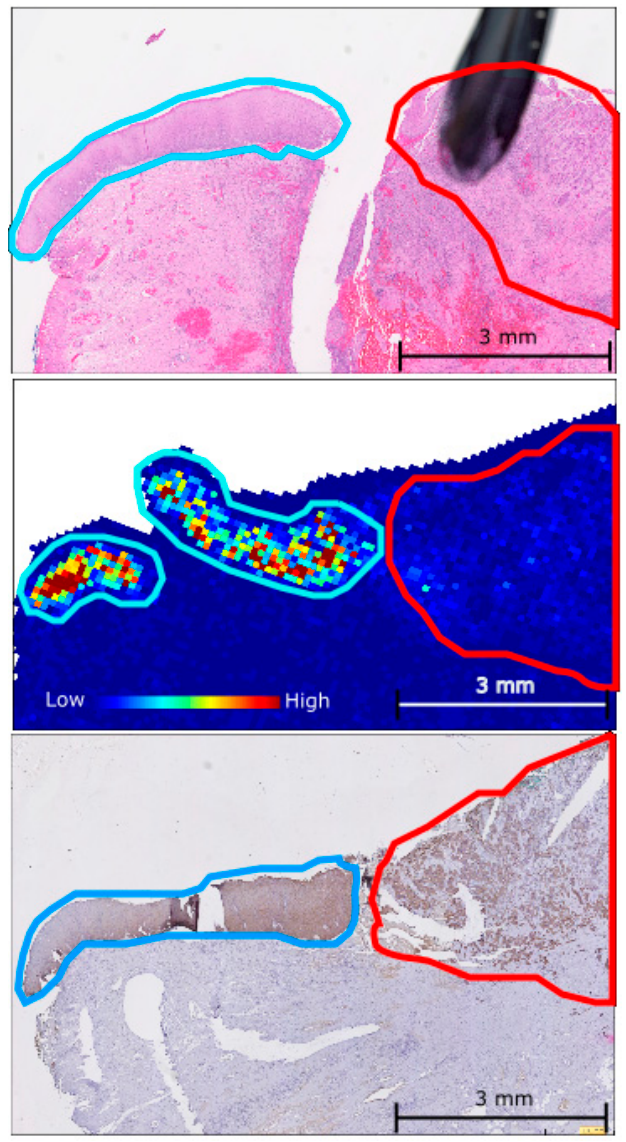
Figure 3. A comparison of the expression pattern observed for the CK5 peptides SFSTASAITPSVSR and TTAENEFVMLKK, both m / z 1410.72, in the dVIN (blue) and VSCC (red) using: MALDI-MSI ion intensity map ( middle ); H & E staining ( top ); and CK5 IHC staining ( bottom ) on consecutively cut vulvar tissue sections.